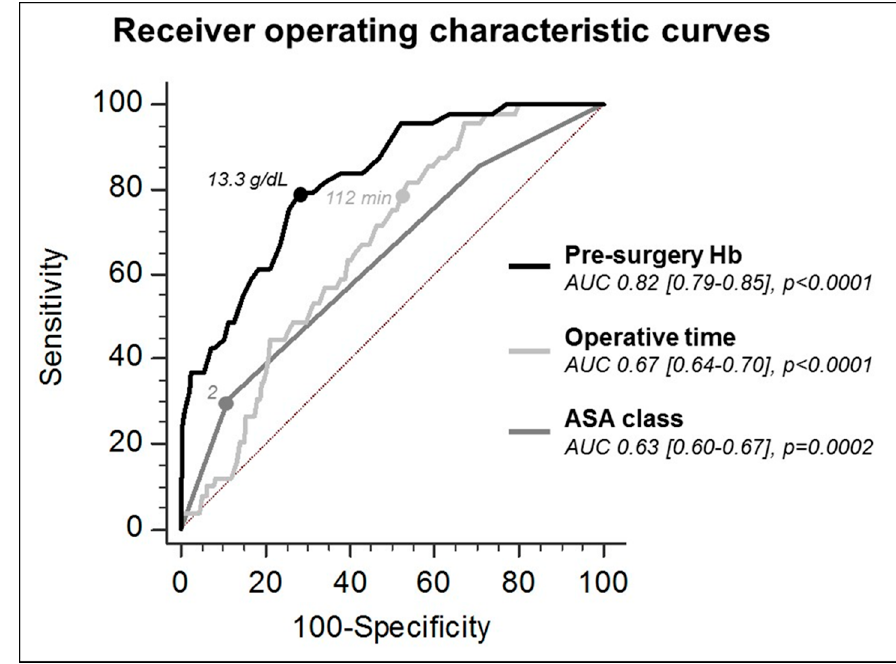
Figure 2. Receiver operator curves (ROC) and area under the curves (AUC) for pre-surgery hemoglobin (HB), American Society of Anesthesiologists (ASA) classification, and operative time for prediction of perioperative red blood cells transfusion.